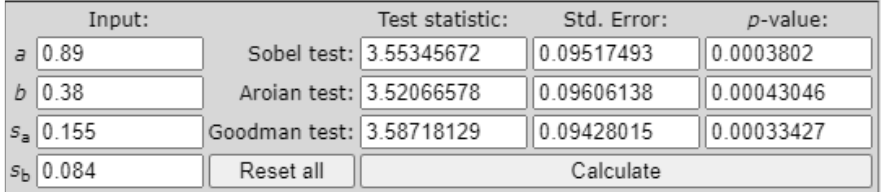
Figure 4: Table of Sobel Test; Source: Data